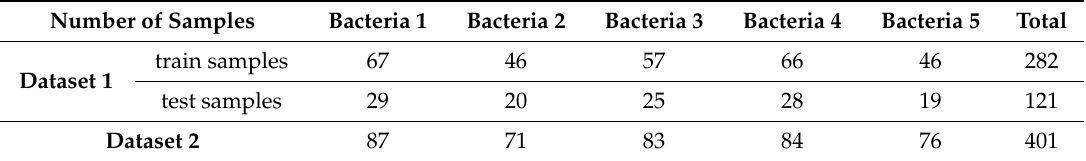
Table 2. Number of samples in each